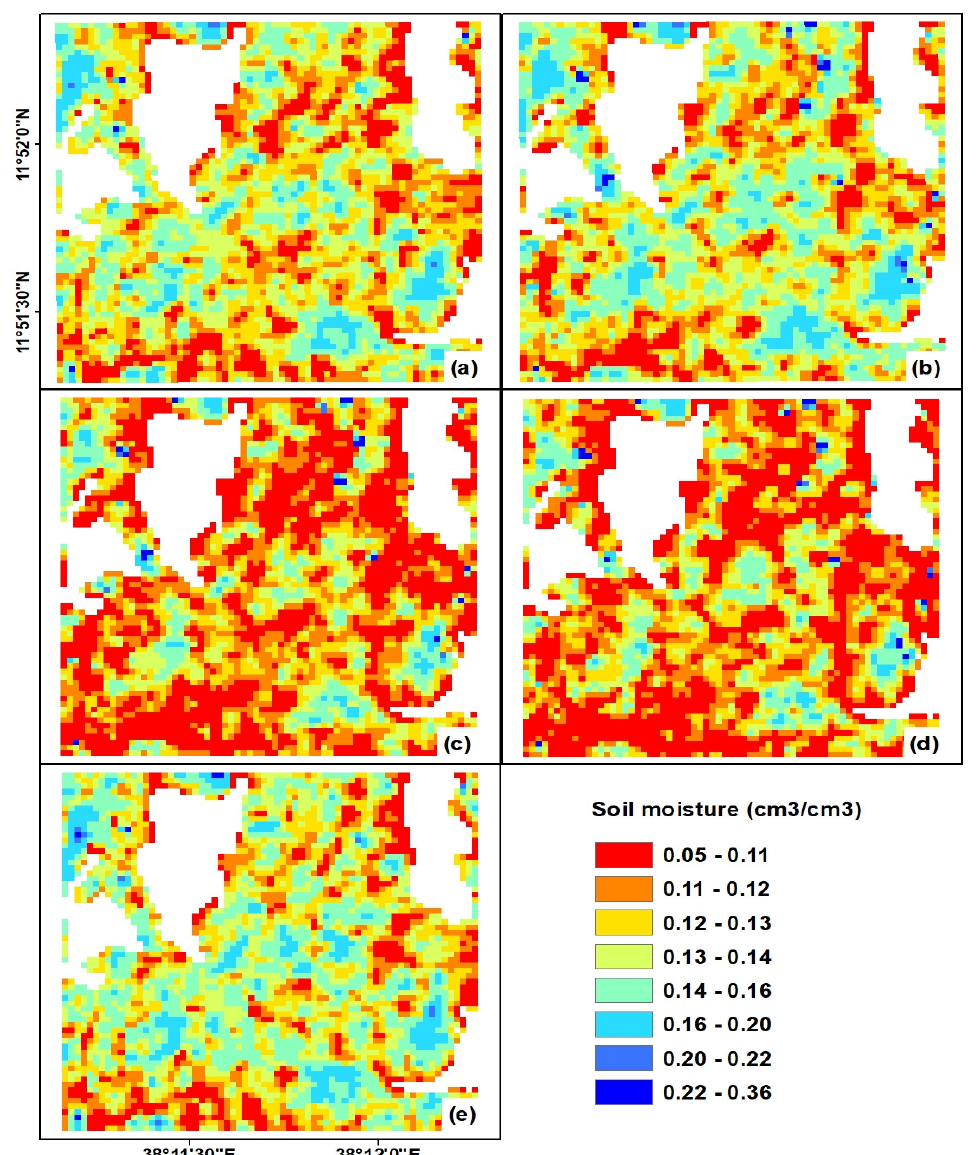
Figure 10. Spatio-temporal estimates of soil moisture based on the LRM method and σ soil _ vv , h rms , and l ef f input variables for: ( a ) 22 November 2016, ( b ) 29 November 2016, ( c ) 16 December 2016, ( d ) 23 December 2016, and ( d ) 2 February 2017.